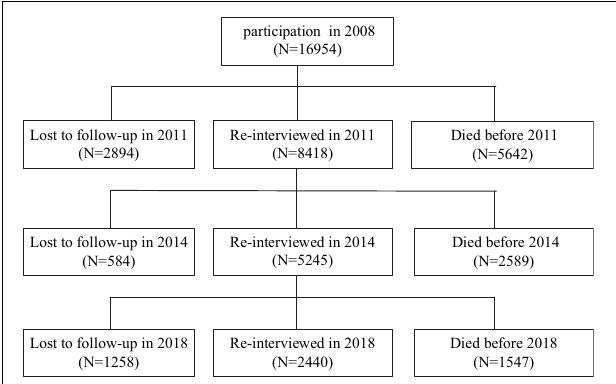
FIGURE 1 | Source of sample